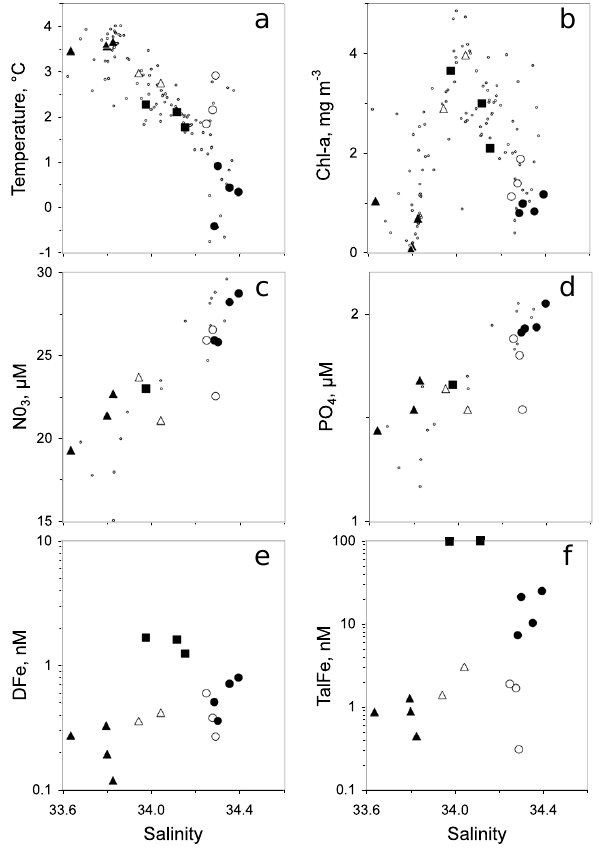
Ardelan et al. Fig. 5 Fig. 5. Mean hydrographic, chemical, and biological values in the upper mixed layer in relation to salinity. (a) temperature; (b) chl- a ; (c) , nitrate; (d) phosphate; (e) , dissolved Fe; (f) , total acid leachable Fe. group A stations ( • ), group B stations ( ◦ ) , group C stations ( 4 ) , group D stations ( N ), group E stations ( (cid:4) ). The stations within each of these five groups are listed in Table 2. The small circles (dots) represent data from all the stations where Fe concentrations were not determined.